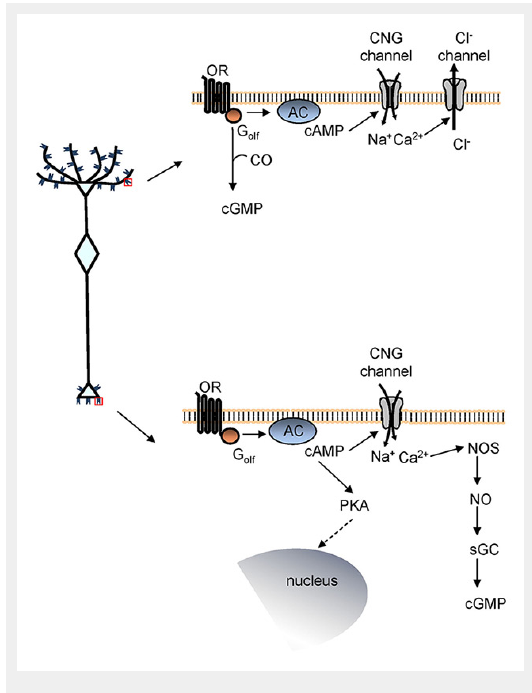
Signalling pathway coupled to the odorant receptor (OR). Left, schematic of an olfactory sensory neuron (OSN). Right, signalling pathway coupled to the OR expressed at the cilia (top) and at the axon terminal (bottom). AC = adenylyl cyclase; CNG channel = cyclic nucleotide-gated channel; CO = carbon monoxide; G olf = olfaction-specific G protein; NO = nitric oxide; NOS = nitric oxide synthase; PKA = protein kinase A; sGC = soluble guanylyl